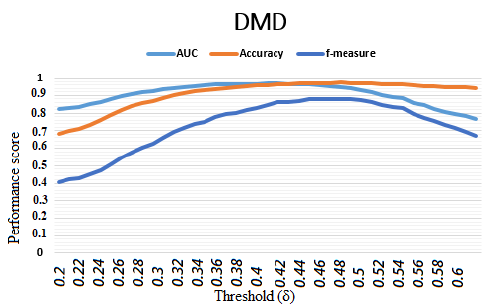
Figure 4. Variation in performance according to the decision threshold ( δ